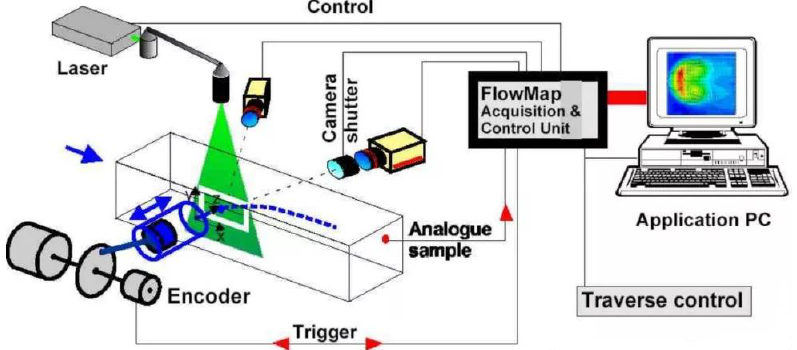
Figure 22. Particle image velocimetry technique (The figure is from https://zhuanlan.zhihu.com/p/446486019 accessed on 2 November 2022.).